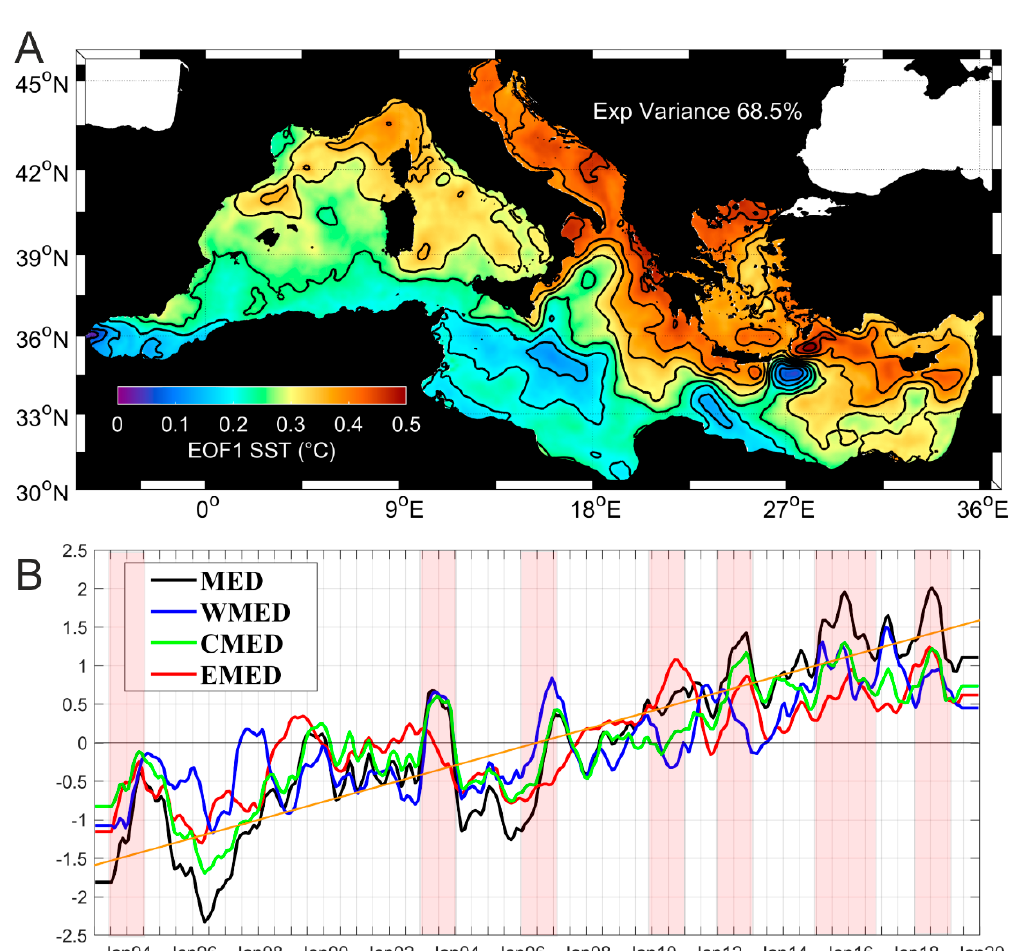
Figure 3. EOF1 ( A ) and PC1s ( B ) of the SST. The PC1s ( B ) are estimated for the whole Mediterranean (MED, black line) and for the three main sub-basins separately (West Mediterranean—WMED, blue line; Central Mediterranean—CMED, green line; Eastern Mediterranean—EMED, red line). The long-term linear trend (orange line) is estimated on the PC1 of MED. Red shaded areas highlight the period characterized by the occurrence of Mediterranean marine heatwaves, as defined by the recent literature [17,80–84].